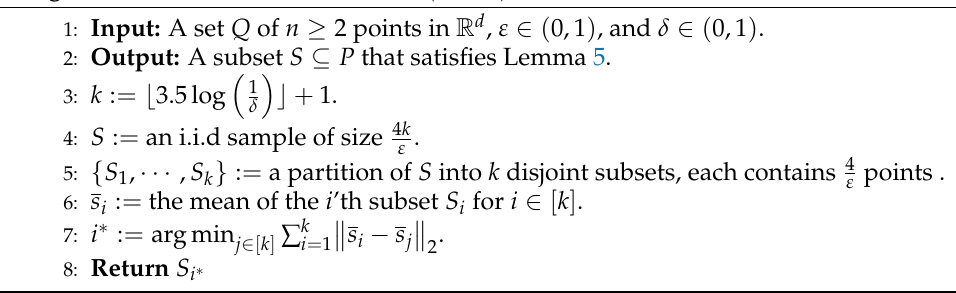
Algorithm 4: P ROB -W EAK -C ORESET ( Q , ε , δ